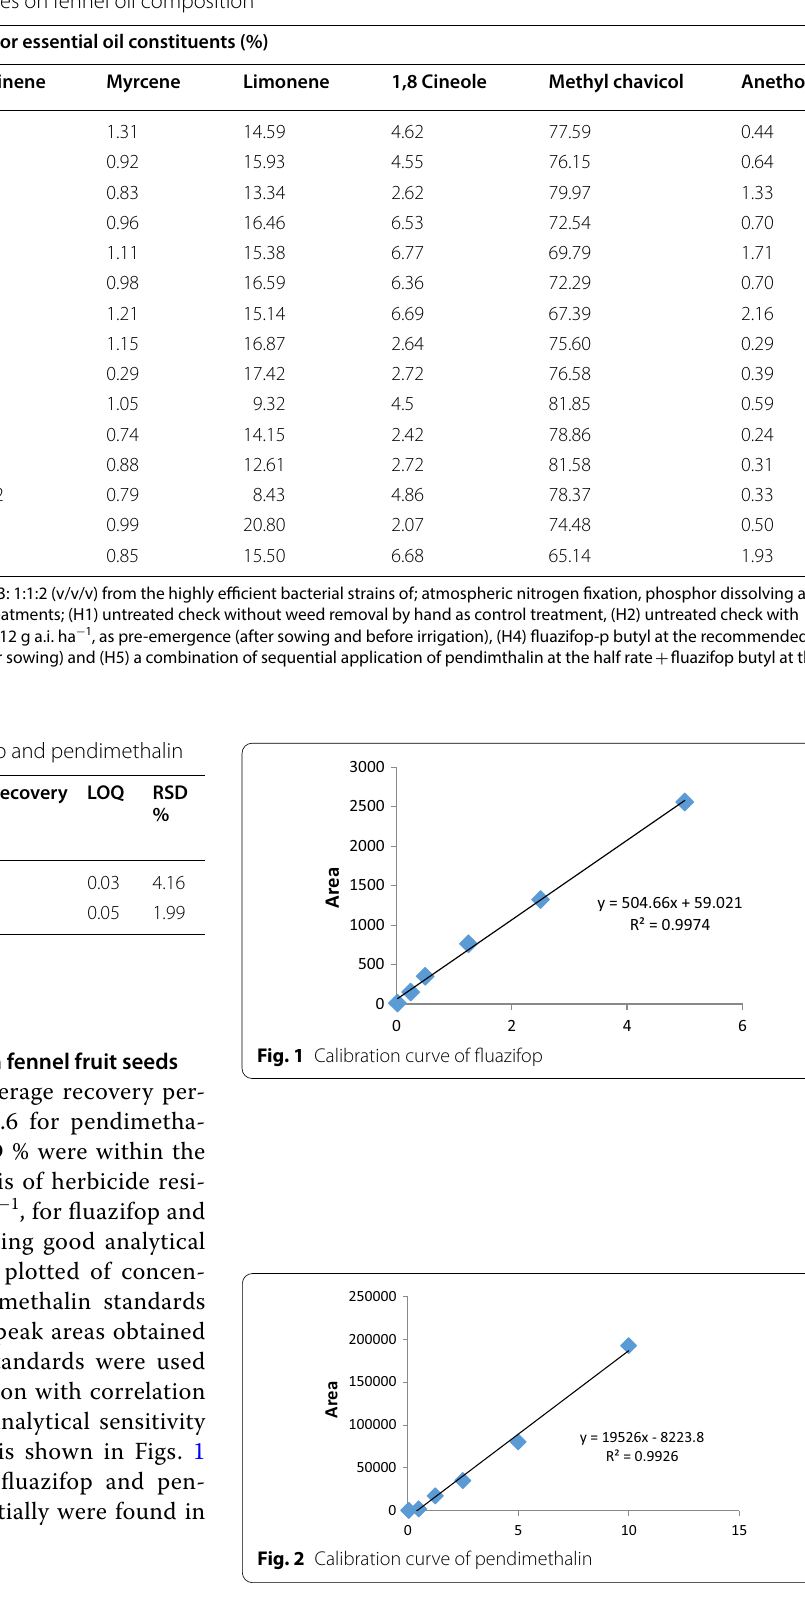
Fig. 2 Calibration curve of